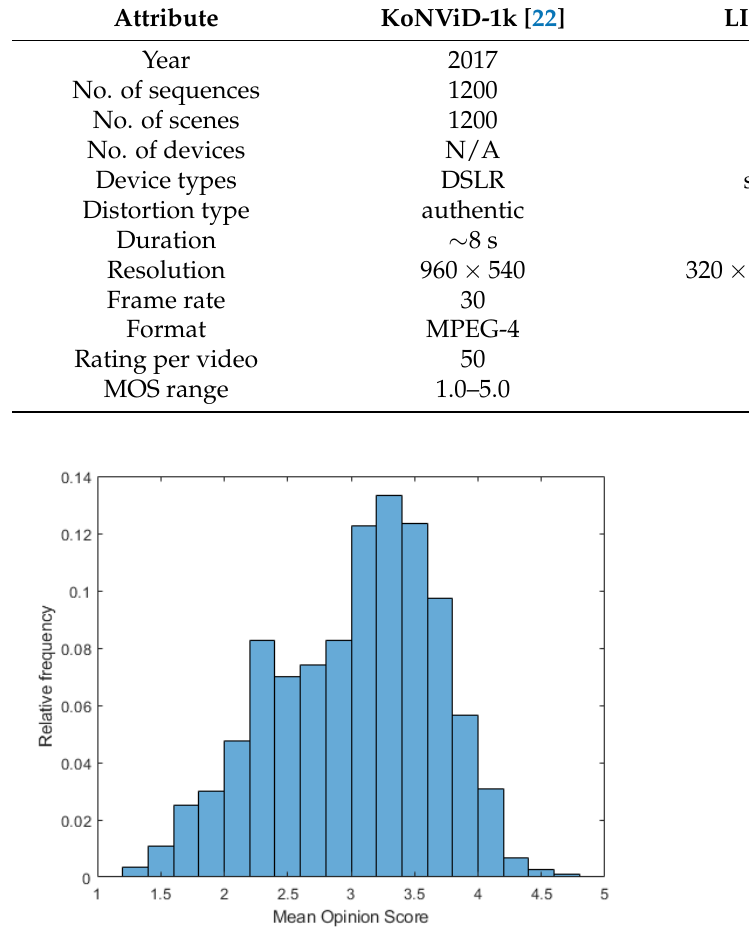
Figure 5. MOS distribution in KoNViD-1k [22].